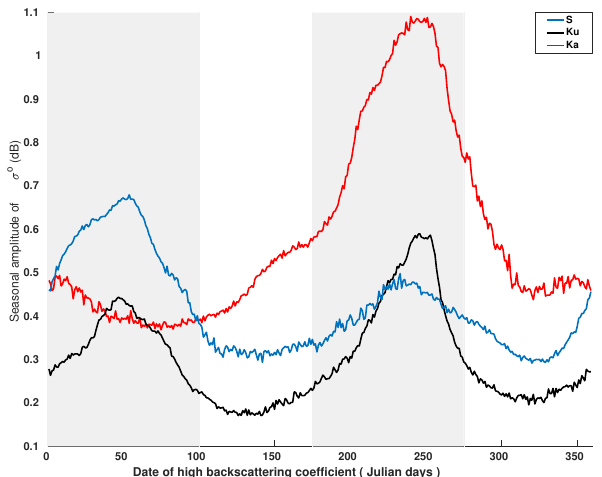
Figure 6. Mean seasonal amplitude with respect to the date of max- imum backscattering coefficient at the S (blue), Ku (black) and Ka (red) bands. The gray bars represent periods referred to as summer (January to April) and winter (June to